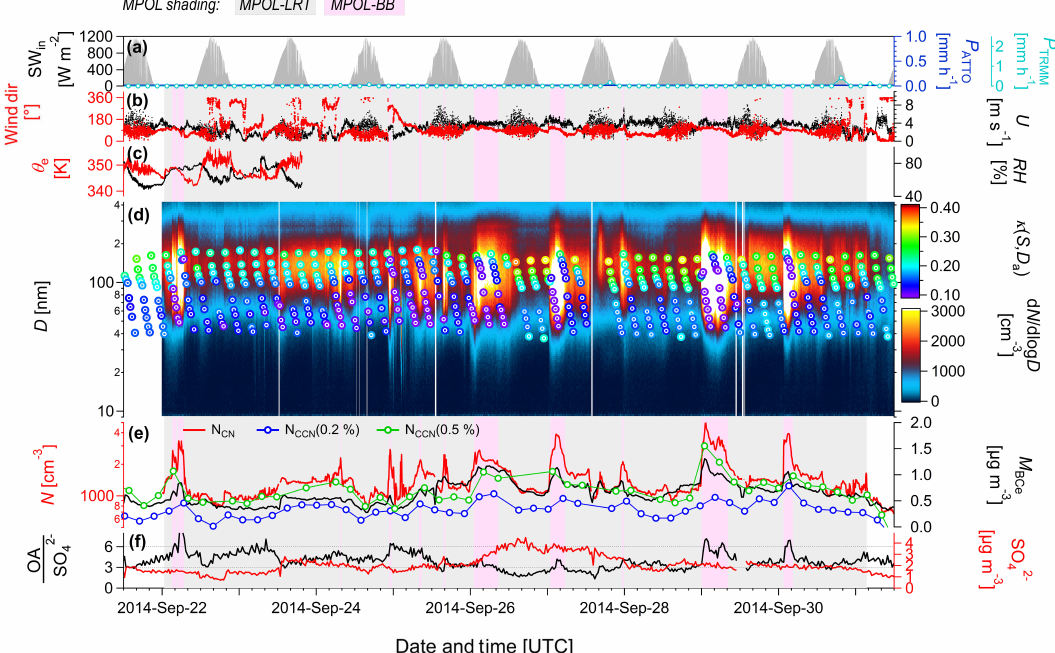
Figure 9. Selected meteorological, aerosol, and CCN time series from ground-based ATTO site measurements for the mixed pollution case study period, MPOL (see Fig. 4). (a) Incoming shortwave radiation, SW in ; precipitation rates from TRMM satellite mission, P TRMM ; and in situ measurements at the ATTO site, P ATTO . (b) Wind direction and wind speed, U , at ATTO. (c) Equivalent potential temperature, θ e , and relative humidity, RH, at ATTO. (d) Overlay of two data layers showing aerosol number size distribution contour plot, d N /dlog D , as well as color-coded markers, representing time series of κ(S,D a ) size distributions. (e) CCN concentrations, N CCN (S ), for two selected S levels; total aerosol number concentration, N CN , 10 ; and BC e mass concentration, M BC . (f) ACSM-derived sulfate mass concentrations and e organic-to-sulfate mass ratio. The vertical shading highlights episodes under the influence of local/regional fires (MPOL-BB) vs. periods that are dominated by long-range transport of African aerosols